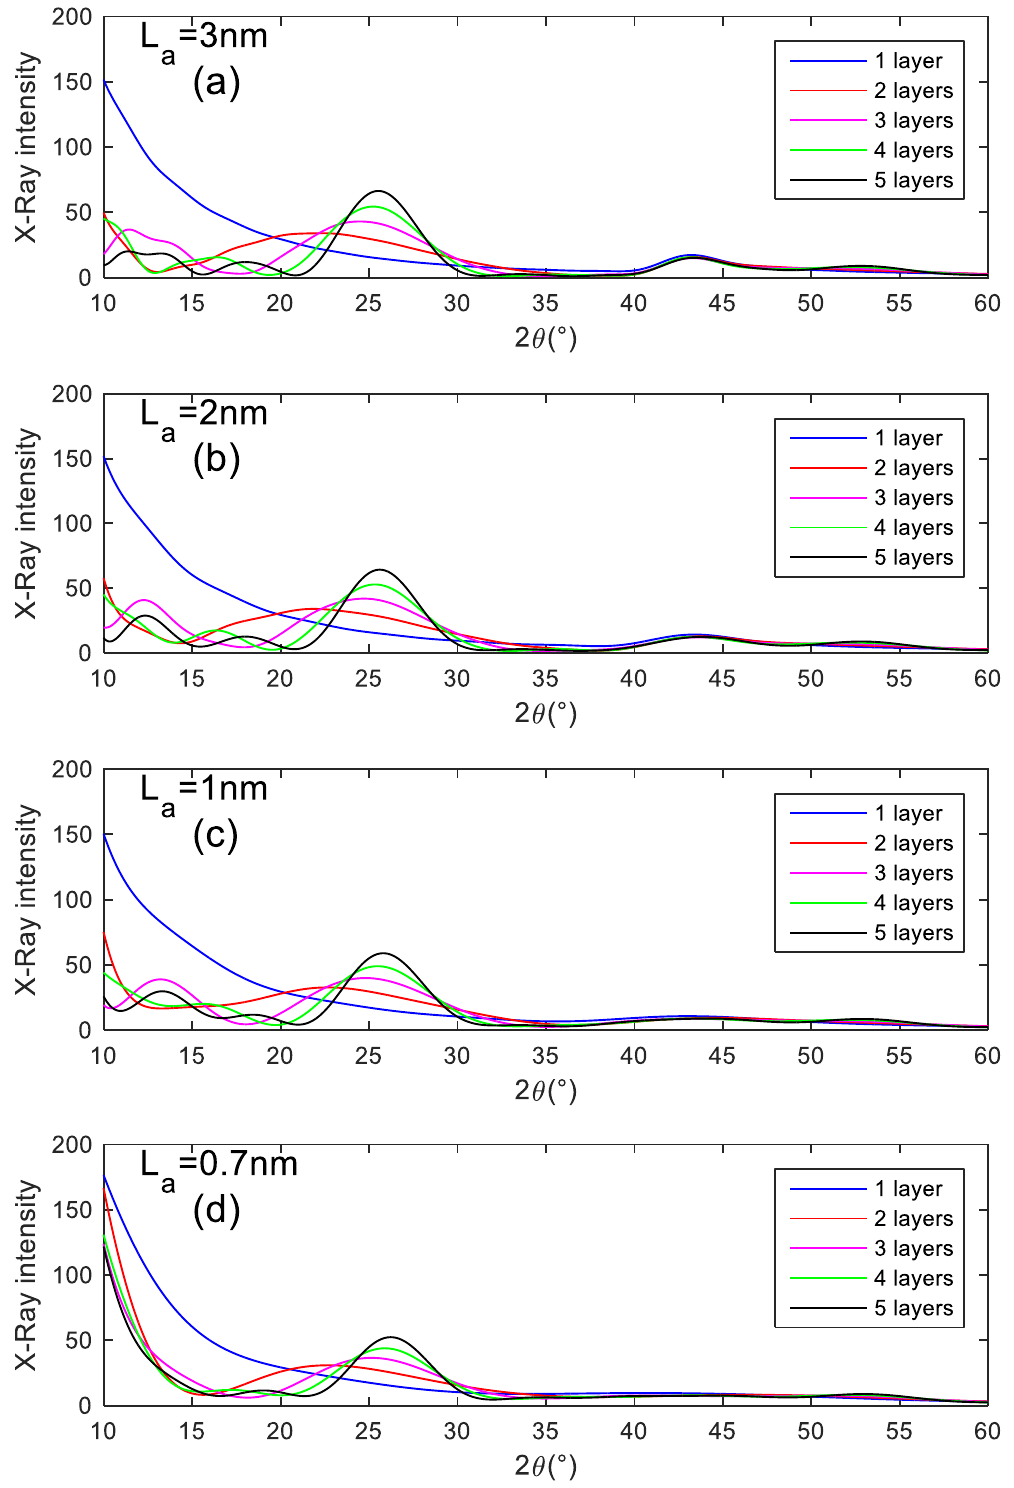
Figure 3. Simulated X-ray diffraction patterns for turbostratic carbon crystallites with the same L a and a number of graphenes varying from 1 to 5. ( a – d ) L a equals 3, 2, 1, and 0.7 nm, respectively. Each curve corresponds to an average of 10 different configurations (random sequences of plane rotations and positions). The intensity is per carbon